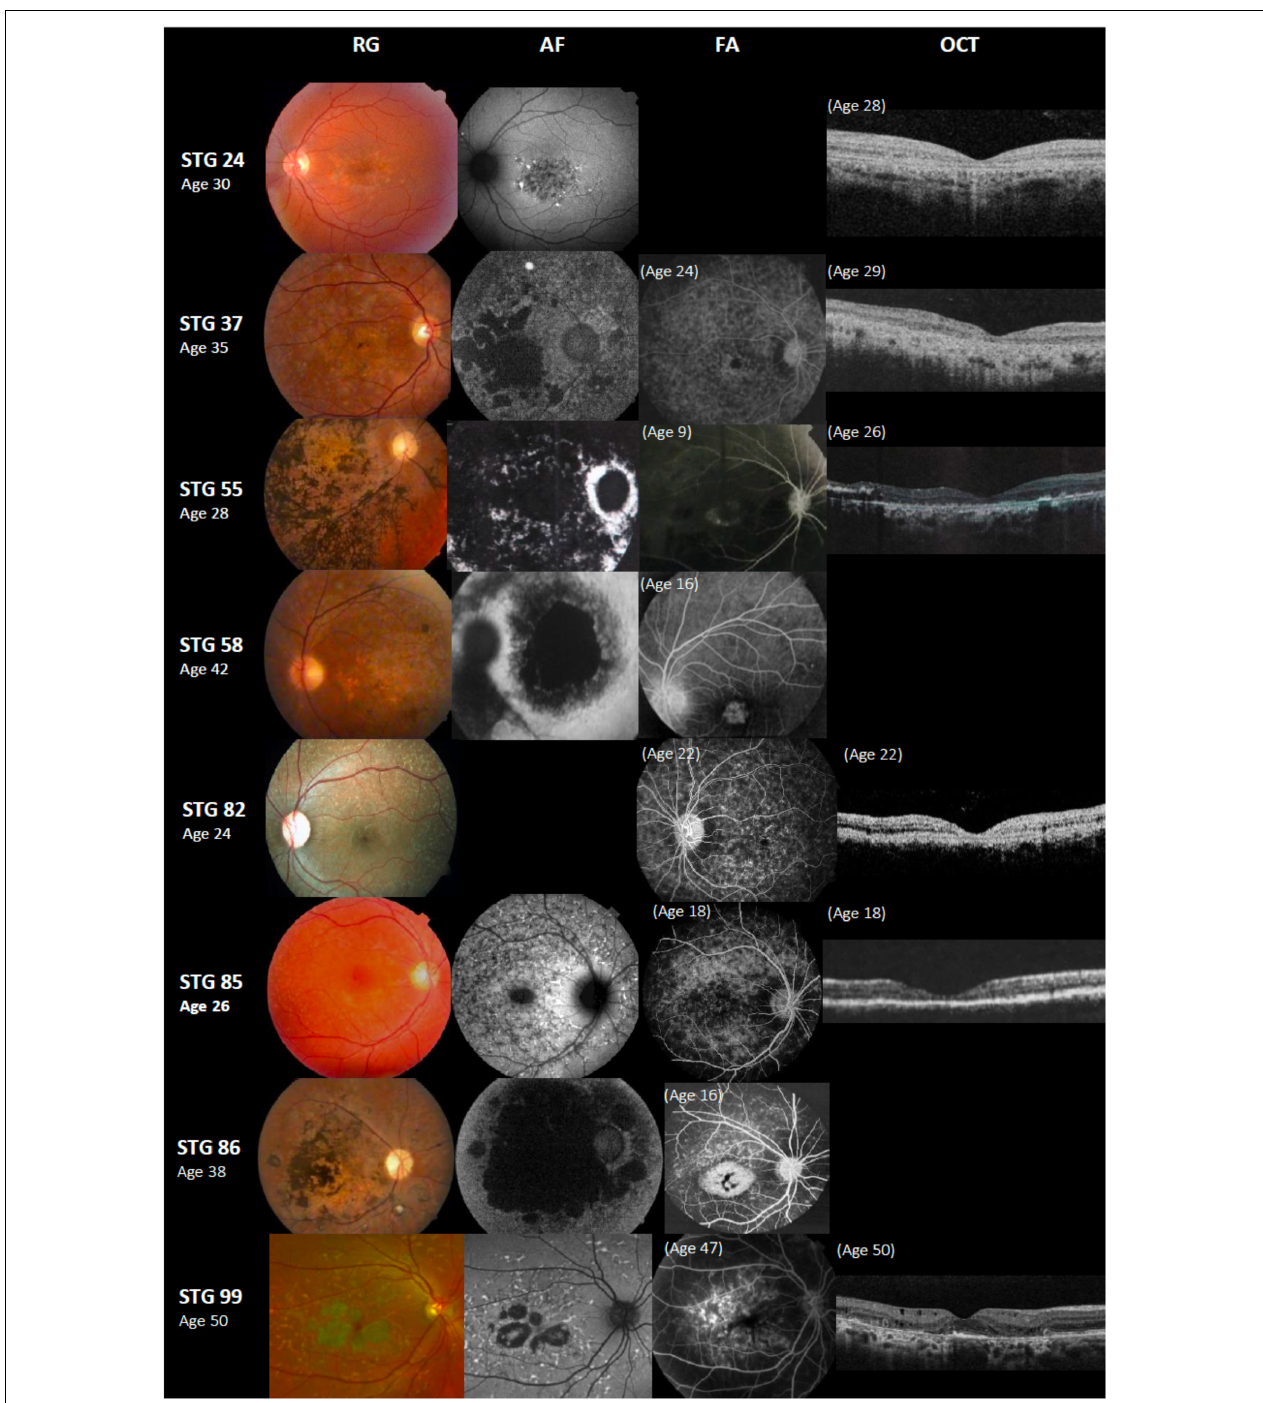
FIGURE 3 | Color fundus photographs (RG), autofluorescence (AF), fluorescein angiography (FA), and optical coherence tomographic images (OCT) of eight patients with novel ABCA4 variants. All of the shown cases had early onset except STG 24, STG 82, and STG 99. Patients STG 24, STG 37, STG 55, STG 82, and STG 85 present central atrophy with macular and peripheral flecks (fundus grade: 3b) on RG images; AF images demonstrate low AF signal at the macula and posterior pole as black lesions corresponding to cells death of retinal pigment epithelium and photoreceptors. The available OCT images in these patients present severe decreased retinal thickness below 150 µ m and absence of external retinal layers. Patient STG 55 presents on FA image at the age of 9 years-old, hyperfluorescent annular lesion showing perifoveal atrophy without flecks (Bull’s eye maculopathy). Further, in the course of the disease with 28 years-old, note on AF how retinal atrophy increases as multiple areas of low AF signal at the posterior pole (AF type 3) and on RG image, there is extensive chorioretinal atrophy with large bone